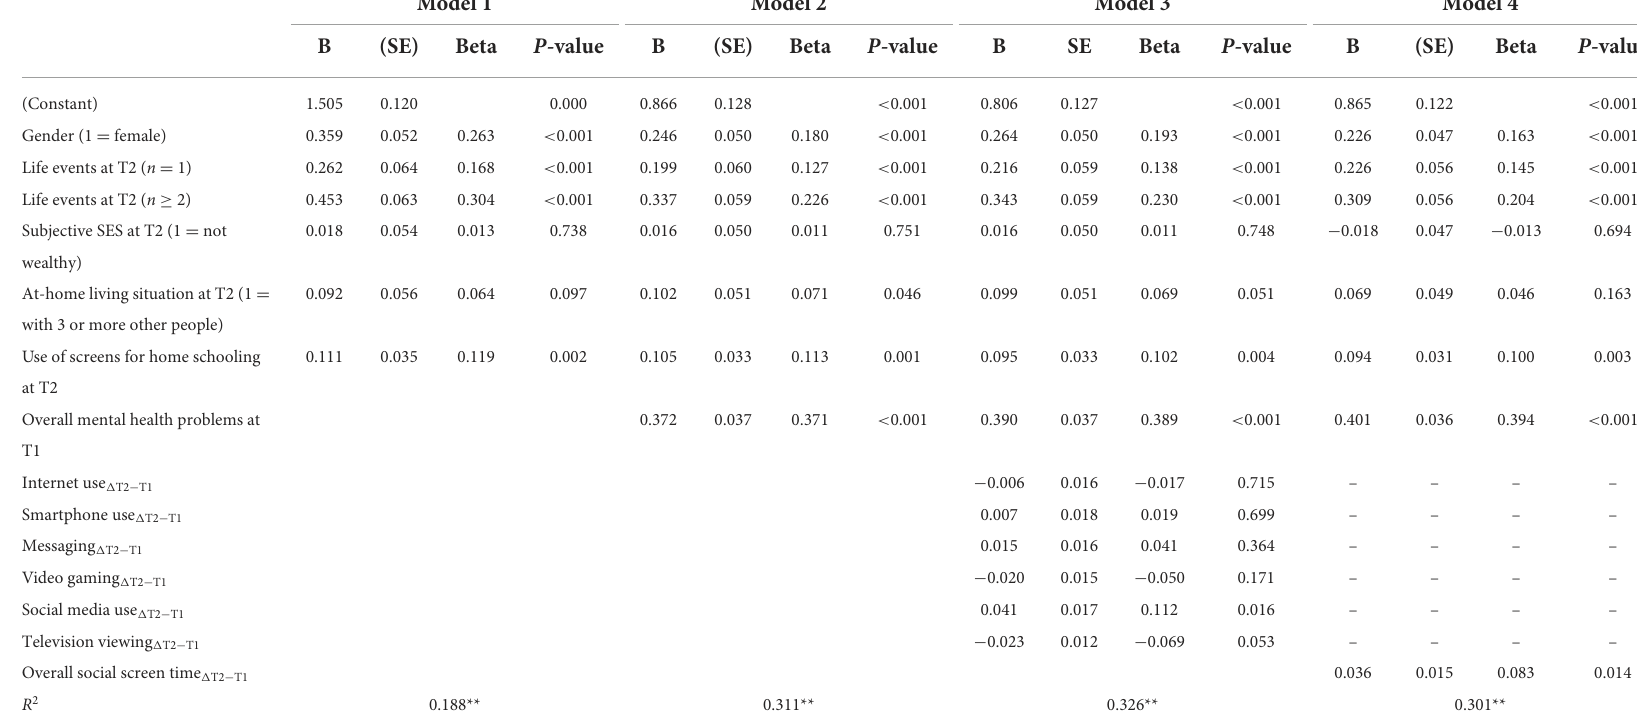
TABLE 3 Hierarchical regression results with Mental health problems at T2 as